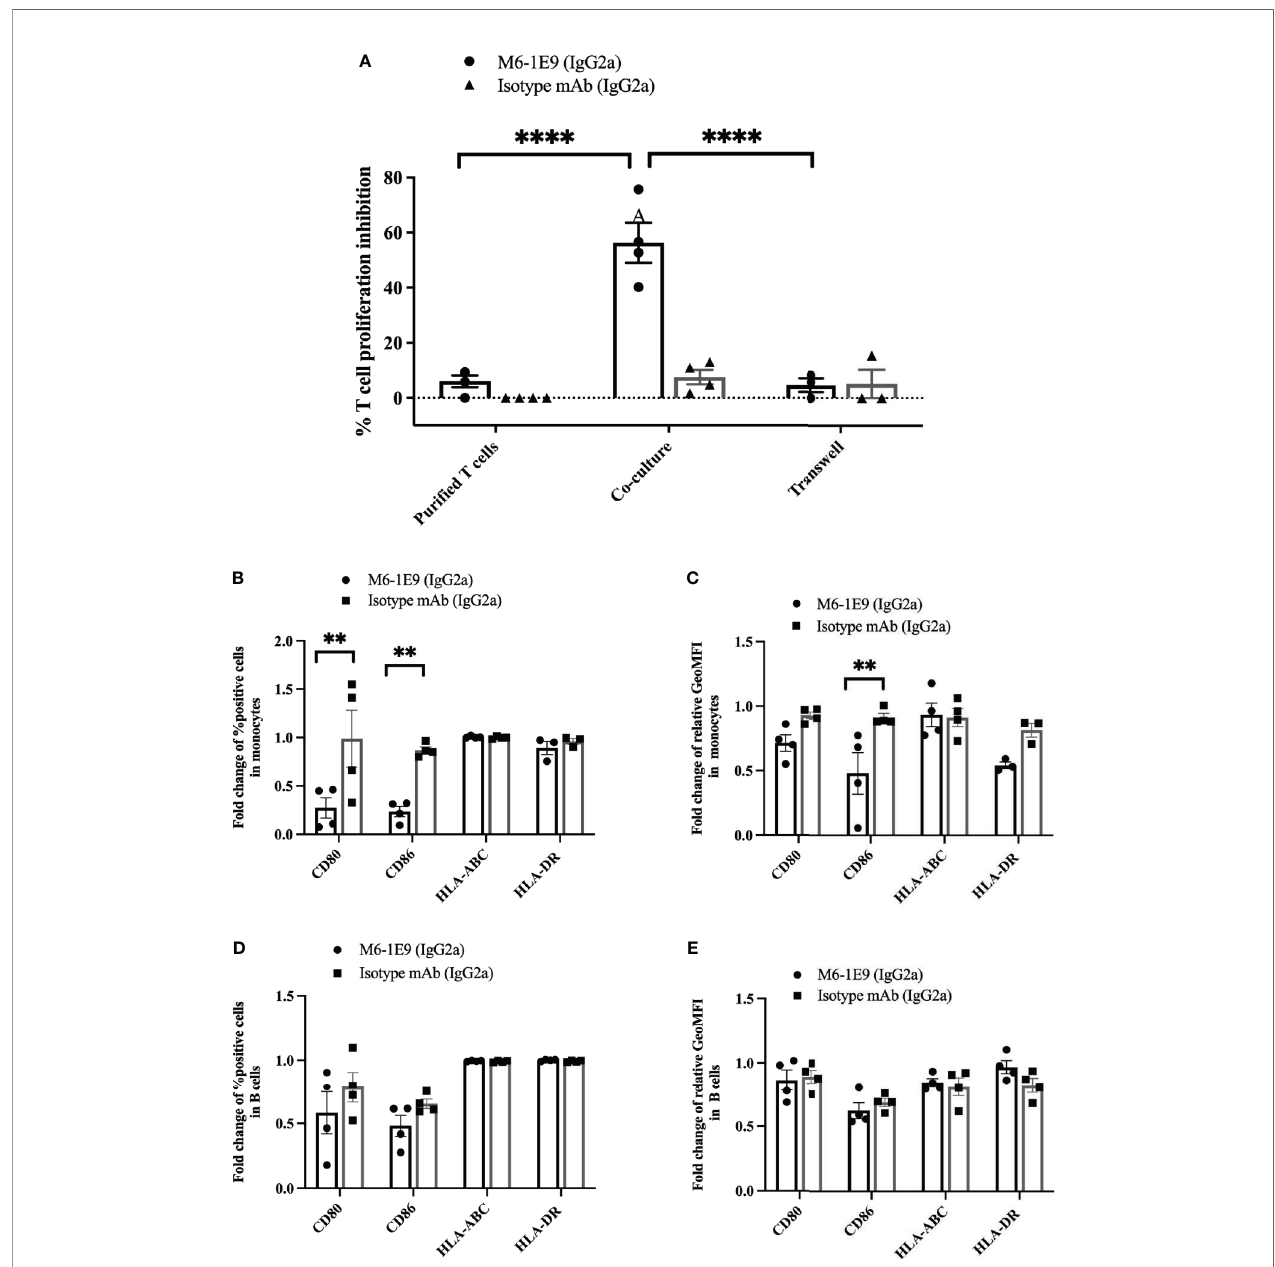
FIGURE 4 | Activation of CD147 on monocytes by the anti-CD147 mAb M6-1E9 regulates T cell activation. Puri fi ed T cells and puri fi ed T cells cocultured with autologous puri fi ed monocytes were activated with anti-CD3 mAb in the absence or presence of mAb M6-1E9 or isotype-matched control mAb. The percent divided T cells under the indicated conditions is shown ( n = 4). (A) . Two-way ANOVA followed by Tukey ’ s test was used for comparison. PBMCs were activated with anti- CD3 mAb in the absence or presence of mAb M6-1E9 or isotype-matched control mAb. The fold changes of percent CD80-, CD86-, MHC class I (HLA-ABC)-, and MHC class II (HLA-DR)-positive cells on CD14 + monocytes (B) and CD19 + B cells (D) are shown in the graph and indicate the mean ± SE. Surface expression levels of CD80, CD86, MHC class I (HLA-ABC), and MHC class II (HLA-DR) on CD14 + monocytes (C) and CD19 + B cells (E) were normalized to the medium control. An unpaired t-test was used for comparison, and ** represents p ≤ 0.01 and ****P <